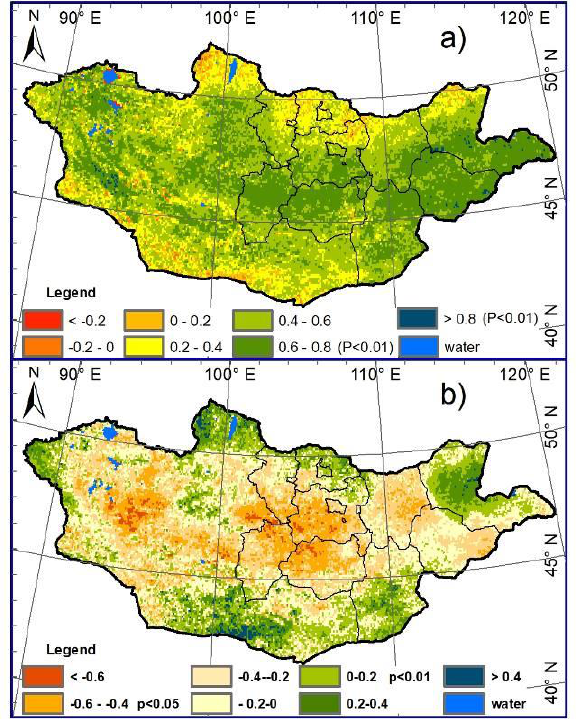
Figure 8. Spatial correlation a) precipitation and NPP b) temperature and NPP between